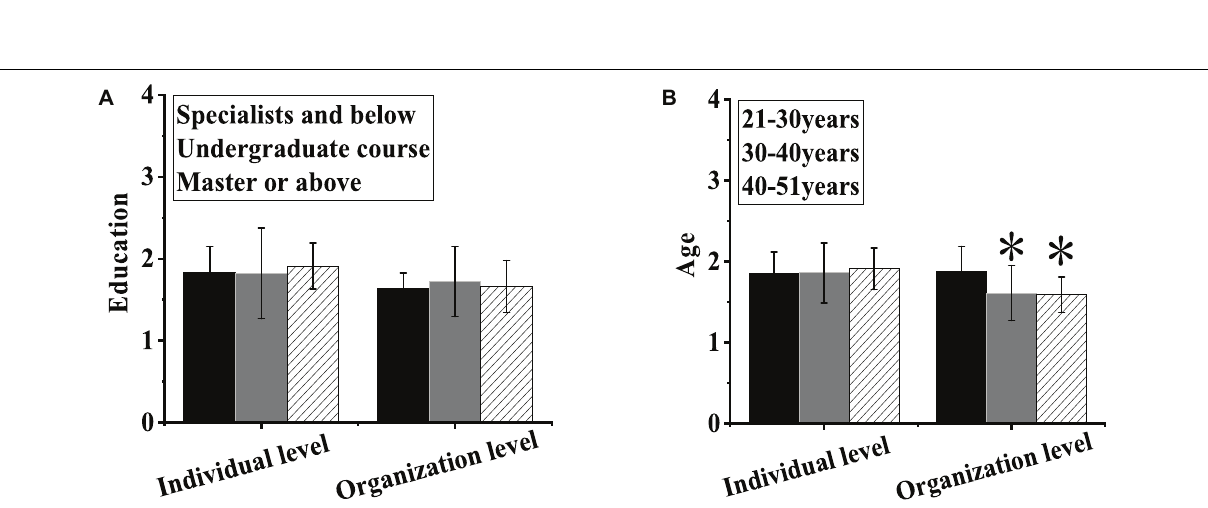
Frontiers in Psychology |